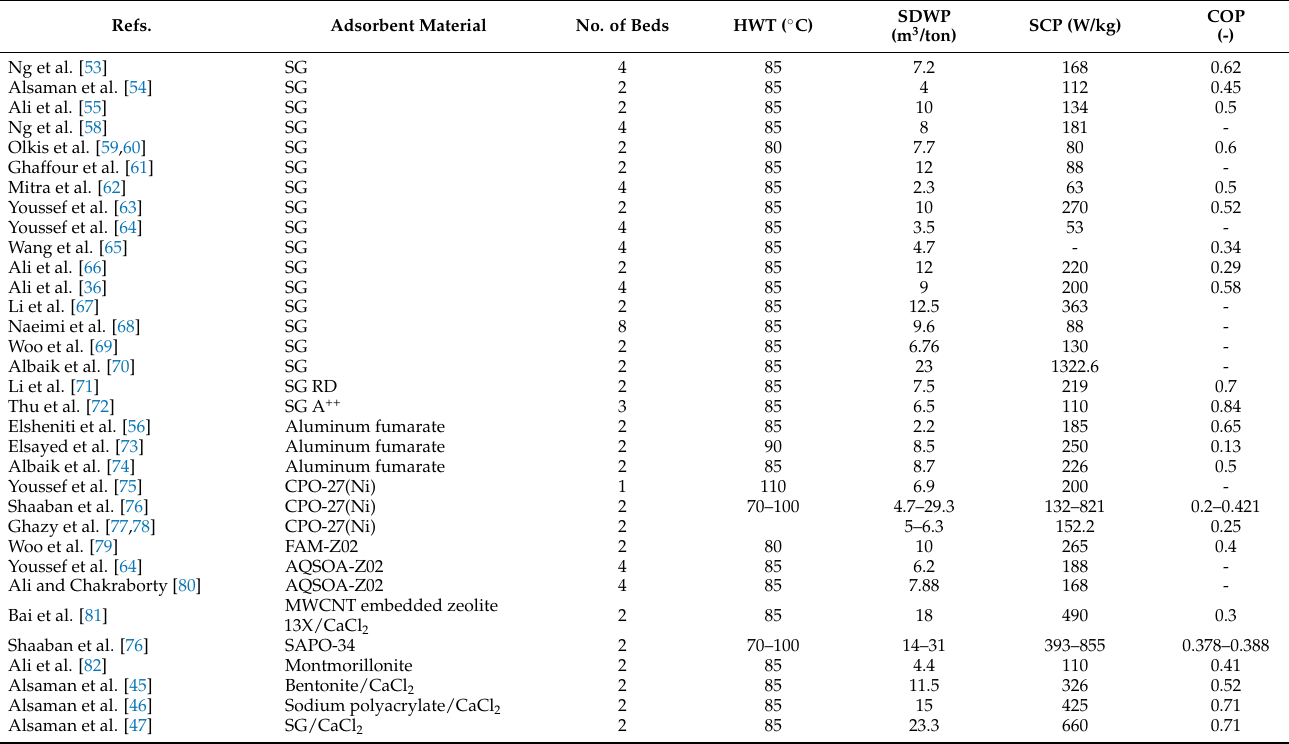
Table 1. Summary of main research covering ADC system